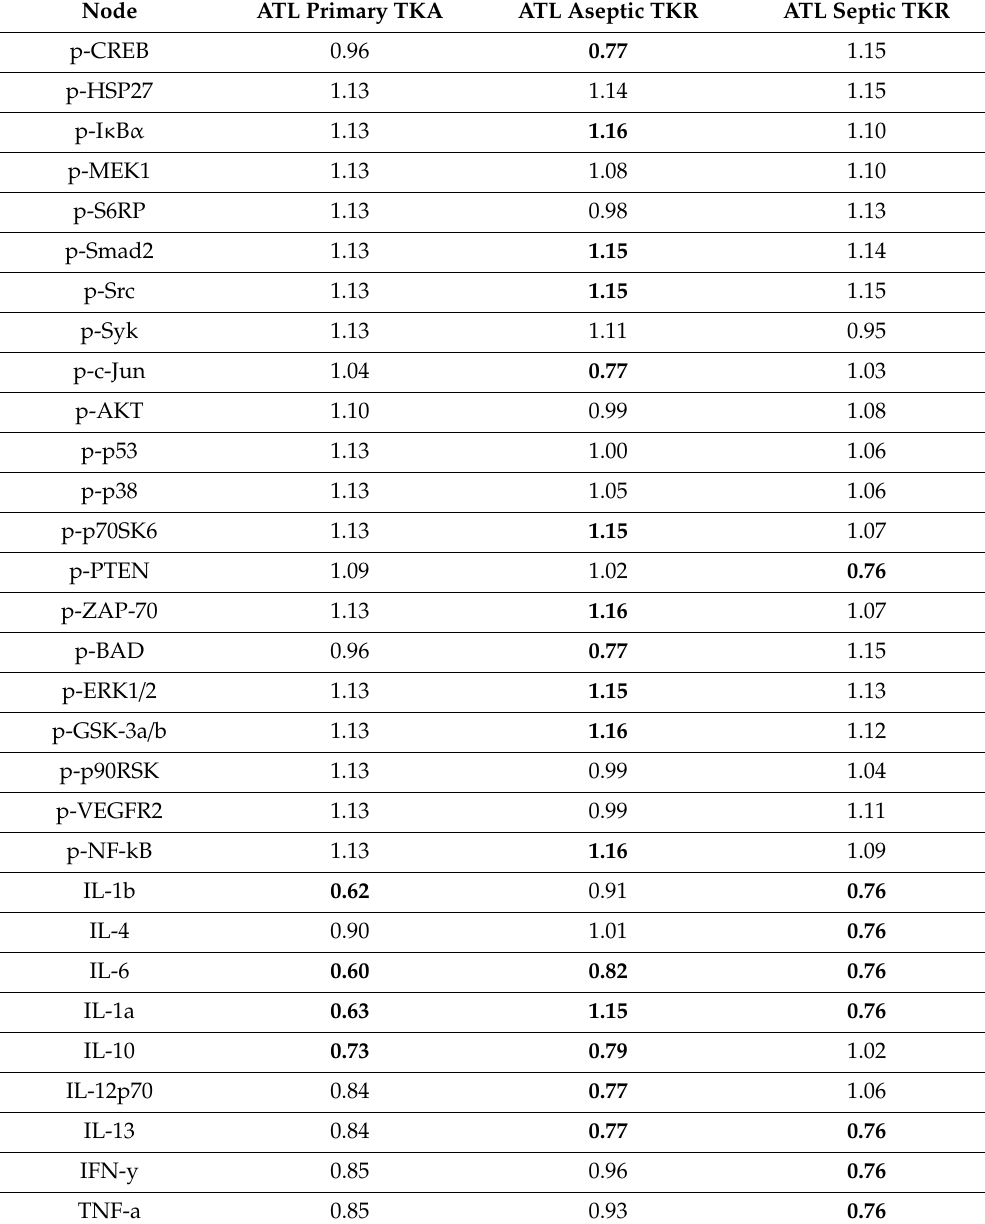
Table 4. Normalized Radiality of Nodes in the ATL Layer. Significant target values for each individual network are bolded (significance threshold: the average radiality ± standard deviation). Node ATL Primary TKA ATL Aseptic TKR ATL Septic TKR p-CREB